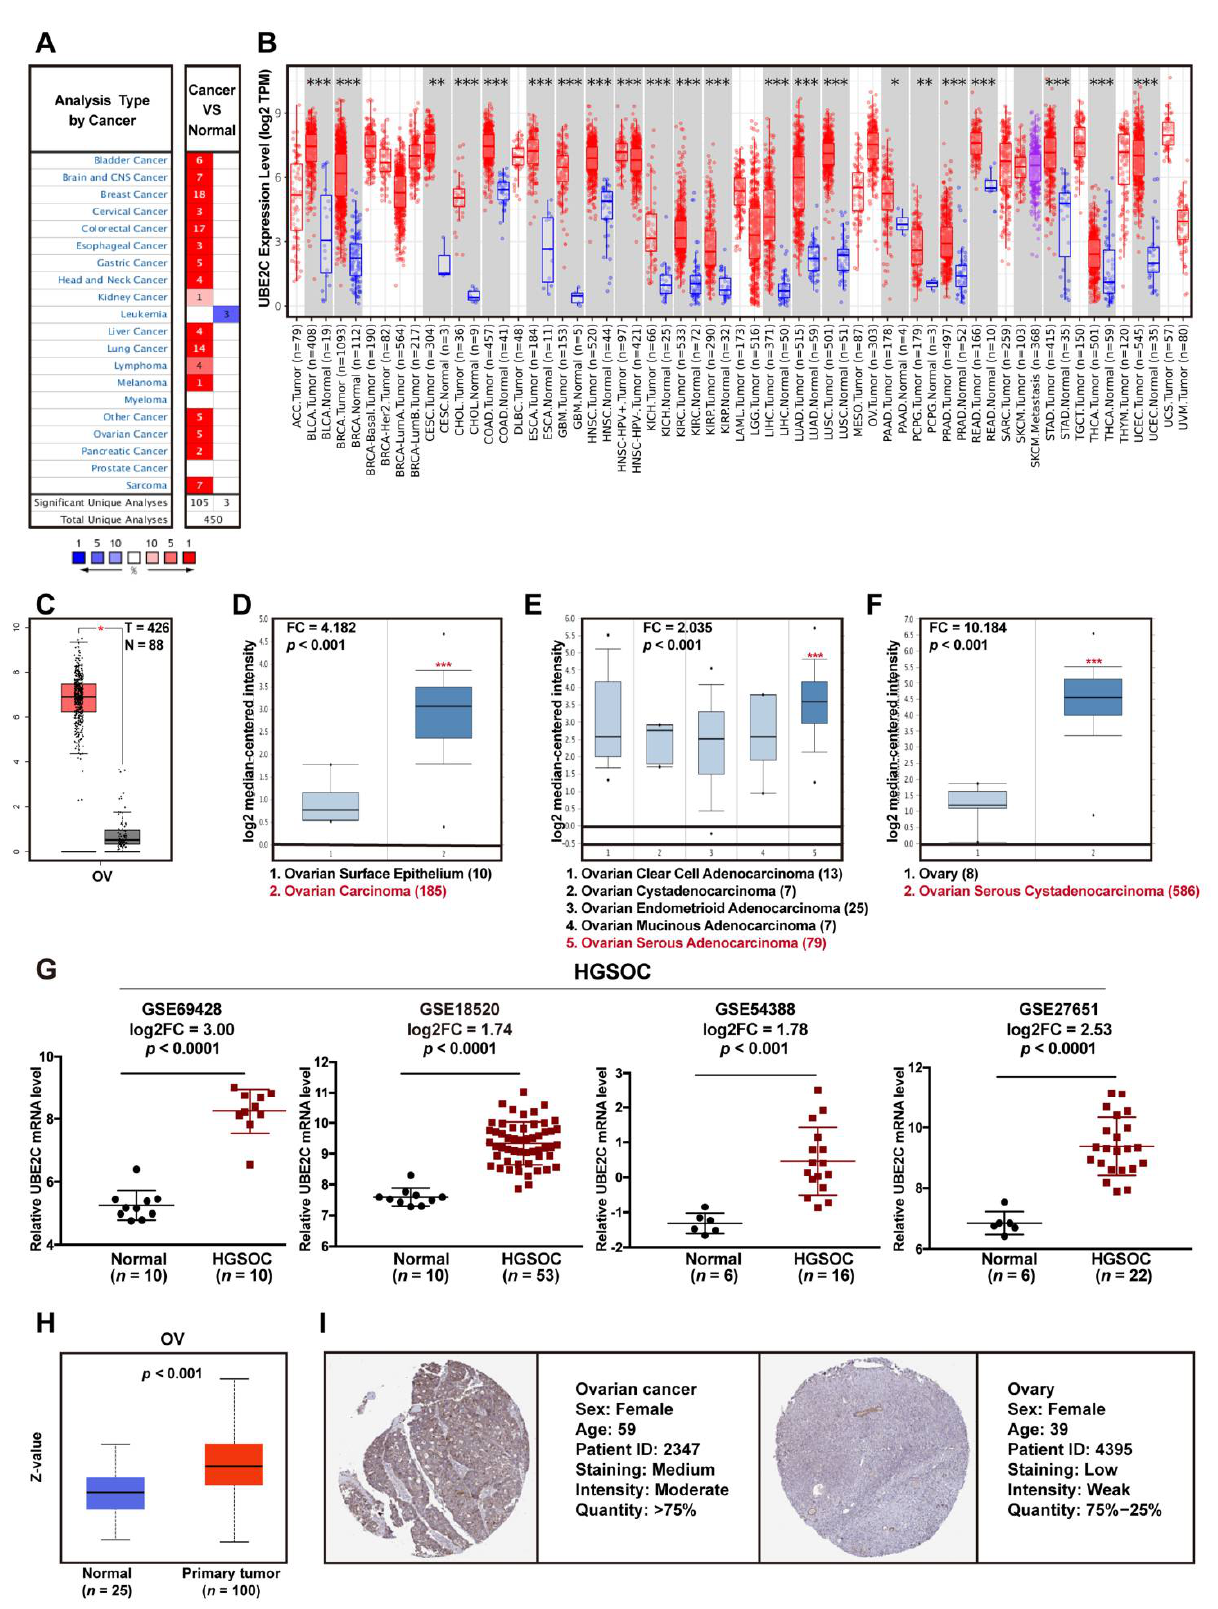
Figure 2. UBE2C gene and protein expression in ovarian cancer. ( A ). The mRNA expression of UBE2C was higher in almost all tumor types than in corresponding normal tissues, according to the analysis of the Oncomine database. ( B ). The mRNA levels of UBE2C were higher in all cancers than